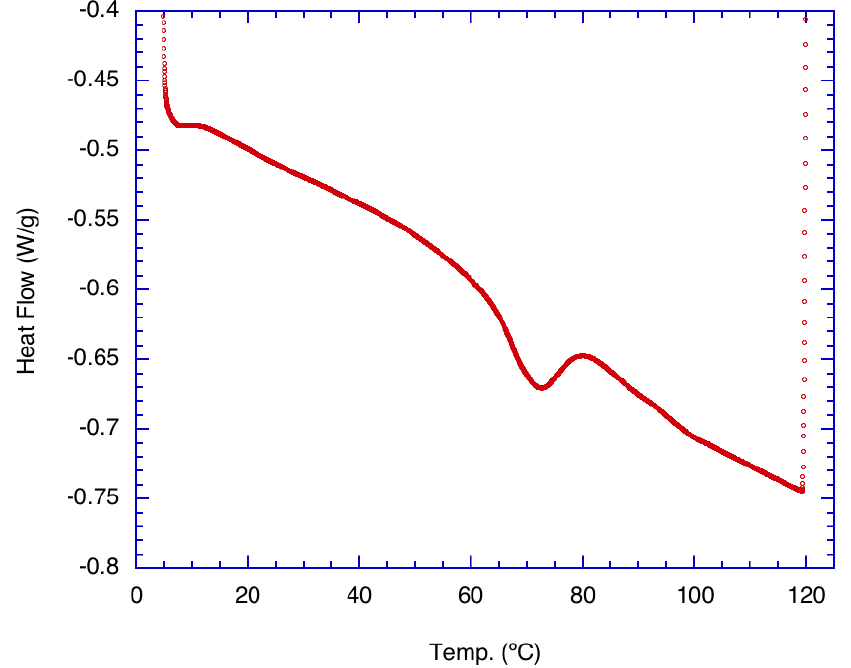
Figure 1. Differential scanning calorimetry (DSC) thermal analysis of purified, freeze-dried alpha glucan synthesized from Leuconostoc mesenteroides NRRL B-1118 glucansucrase.